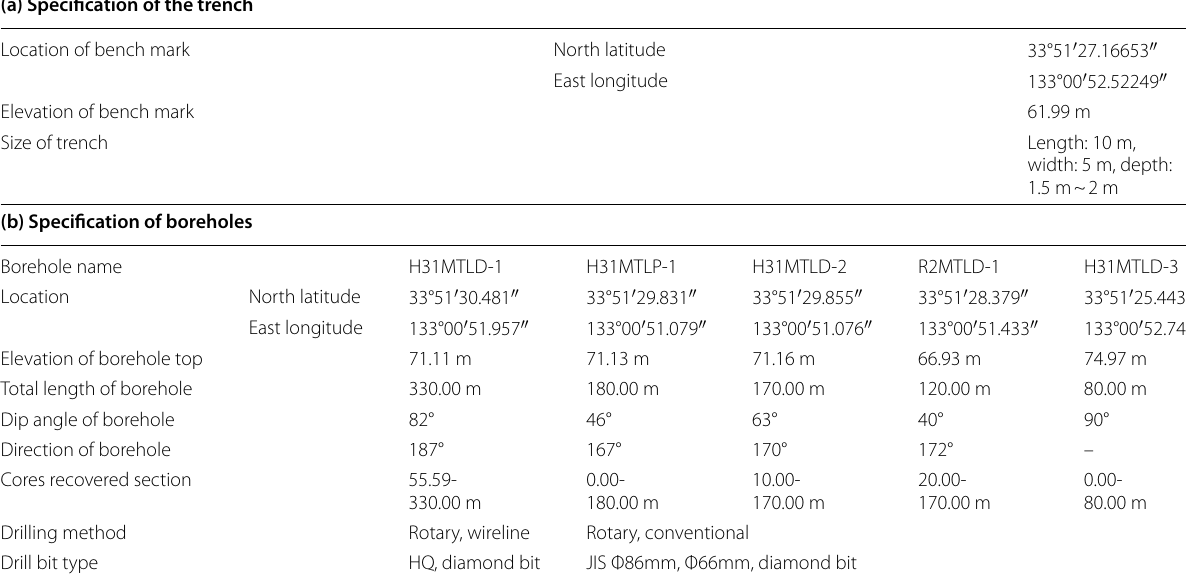
Table 1 Specifications of the trench and the boreholes (a) Specification of the trench Location of bench